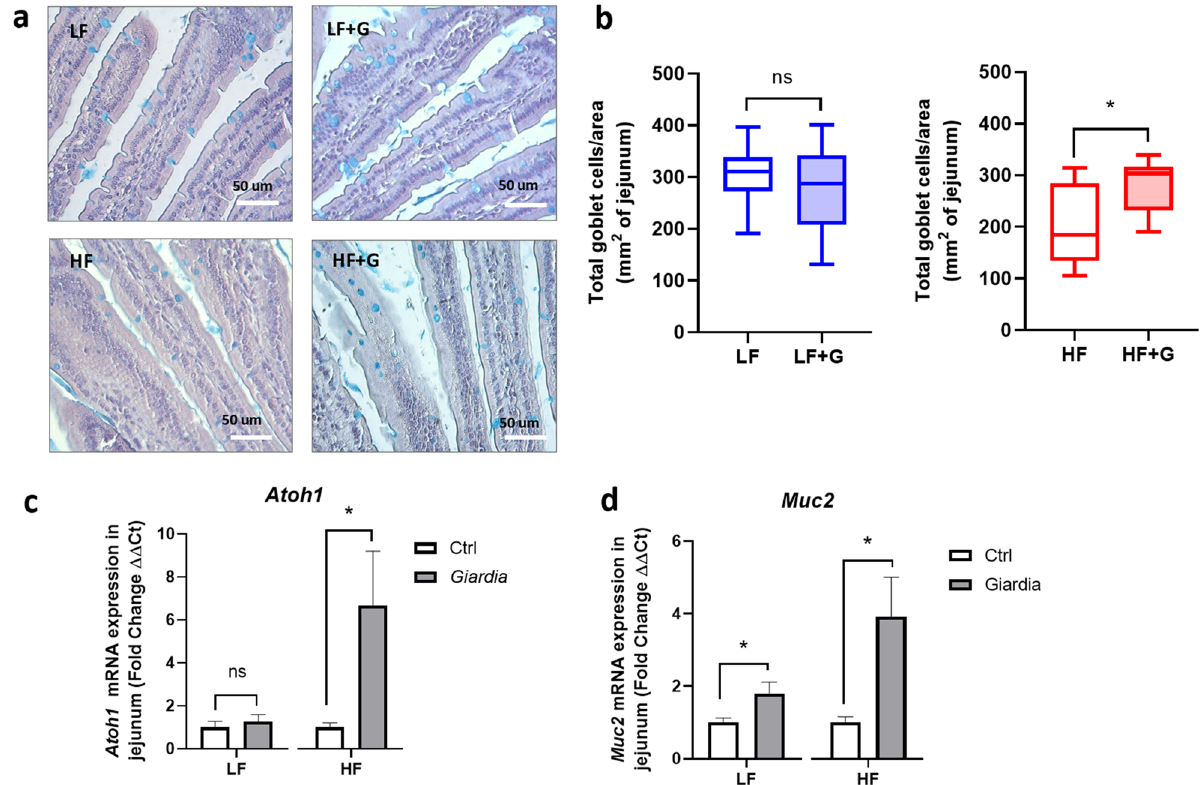
Figure 6. High fat exacerbates Giardia -induced alterations in goblet cell numbers and jejunal mucin gene expression. ( a ) Alcian Blue/PAS staining of jejunal sections of control (LF and HF) and infected (LF + G and HF + G) C57BL/6 mice. Goblet cells are stained in light blue. Scale bar = 50 μm. ( b ) Total goblet cell count per mm 2 of jejunum. Surface area was quantified using ImageJ software. n = 8–9 per group. Data are expressed as box plots with min/max whiskers; * p < 0.05. ( c ) Atoh1 mRNA transcript expression in the jejunum, normalized to β-actin mRNA (2 −ΔΔCt method); n = 8–9. Data are shown as mean ± S.E.M; * p < 0.05. ( d ) Muc2 mRNA transcript expression in the jejunum, normalized to β-actin mRNA (2 -ΔΔCt method). n = 8–9. LF = low fat control mice; LF + G = low fat infected mice; HF = high fat mice; HF + G = high fat infected mice. Data are shown as mean ± S.E.M; * p <